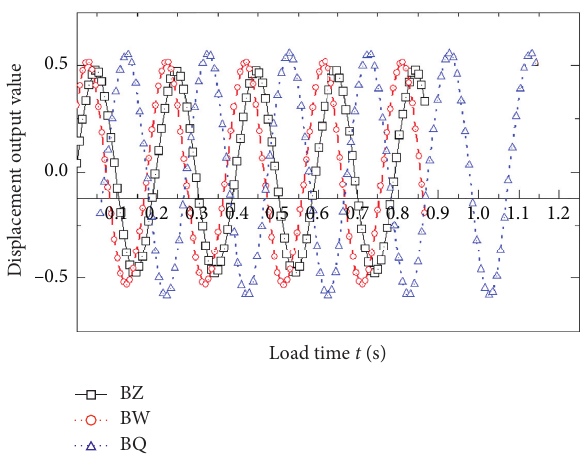
Figure 16: Dynamic displacement of test plate under fatigue loading.